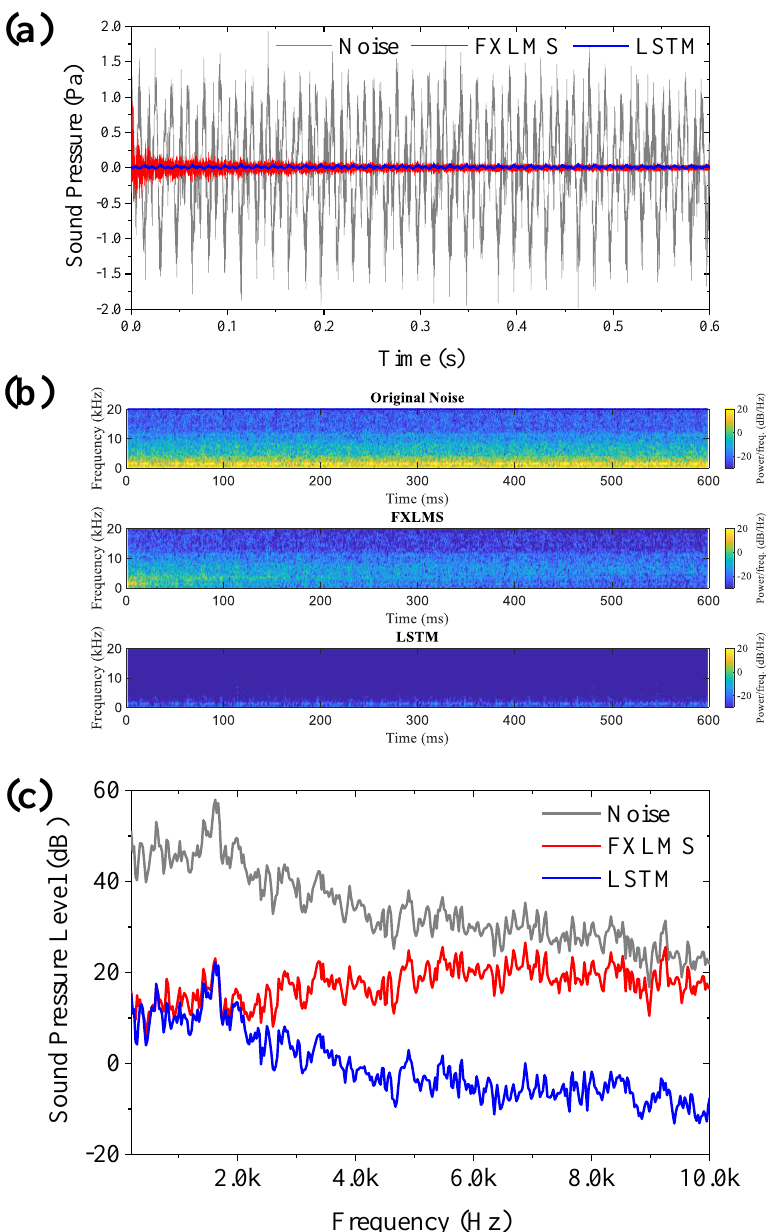
Figure 5. ANC simulation result using FxLMS and LSTM for diesel engine sounds with a main frequency of 60 Hz. ( a ) Time data of the diesel engine noise and ANC results; ( b ) short-time Fourier transform analysis of original noise and noise residue; ( c ) power spectral density of the diesel engine noise and ANC result in the period when the error signal is minimized.